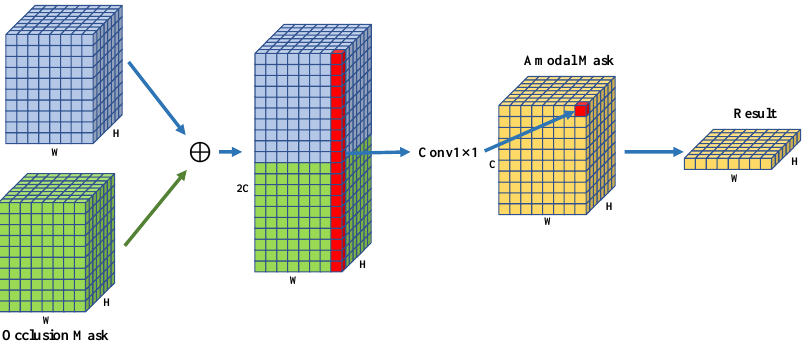
Figure 3. Visible Mask and Occlusion Mask are the output from the visible and occluded mask branches, respectively. The number of channels of the tensor C is the number of categories of instances in the dataset, and W and H are tensors, respectively, Width and height (in this paper, they are both 28). Amodal Mask is the mask predicted by the category of all instances in the dataset. Finally, according to the result of the classification, the mask of the corresponding class is selected as the output